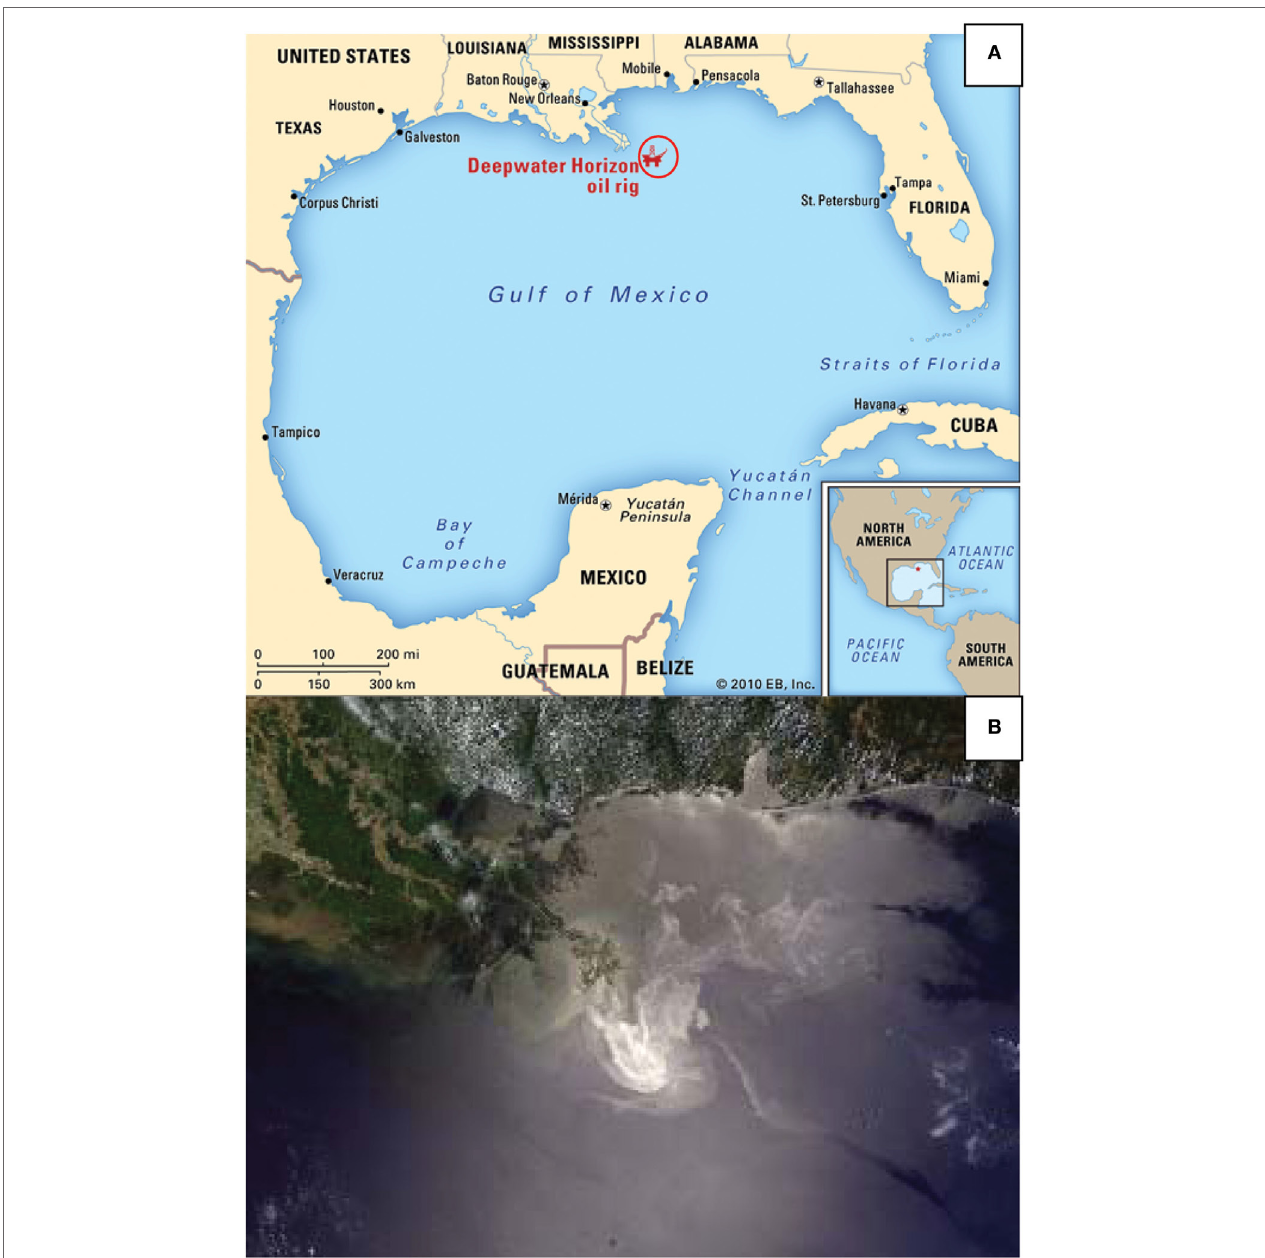
FigUre 1 | The Deepwater Horizon oil drilling rig. (a) The location of the Deepwater Horizon oil rig explosion in the Gulf of Mexico, 50 miles off the Louisiana coast (source: http://www.britannica.com/blogs/2011/04/deepwater-horizon-oil-spill-year-picture-essay-day/ by courtesy of Encyclopedia Britannica, Inc.,